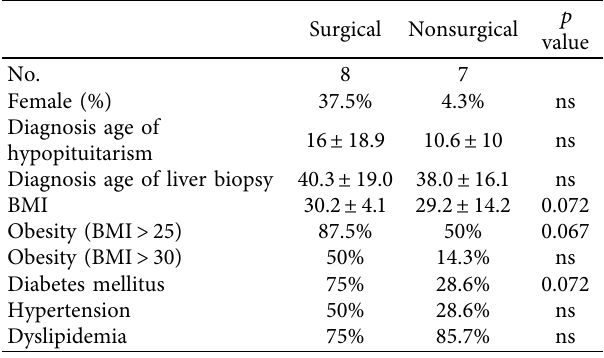
Table 2: Comparison between surgical cases and nonsurgical cases.